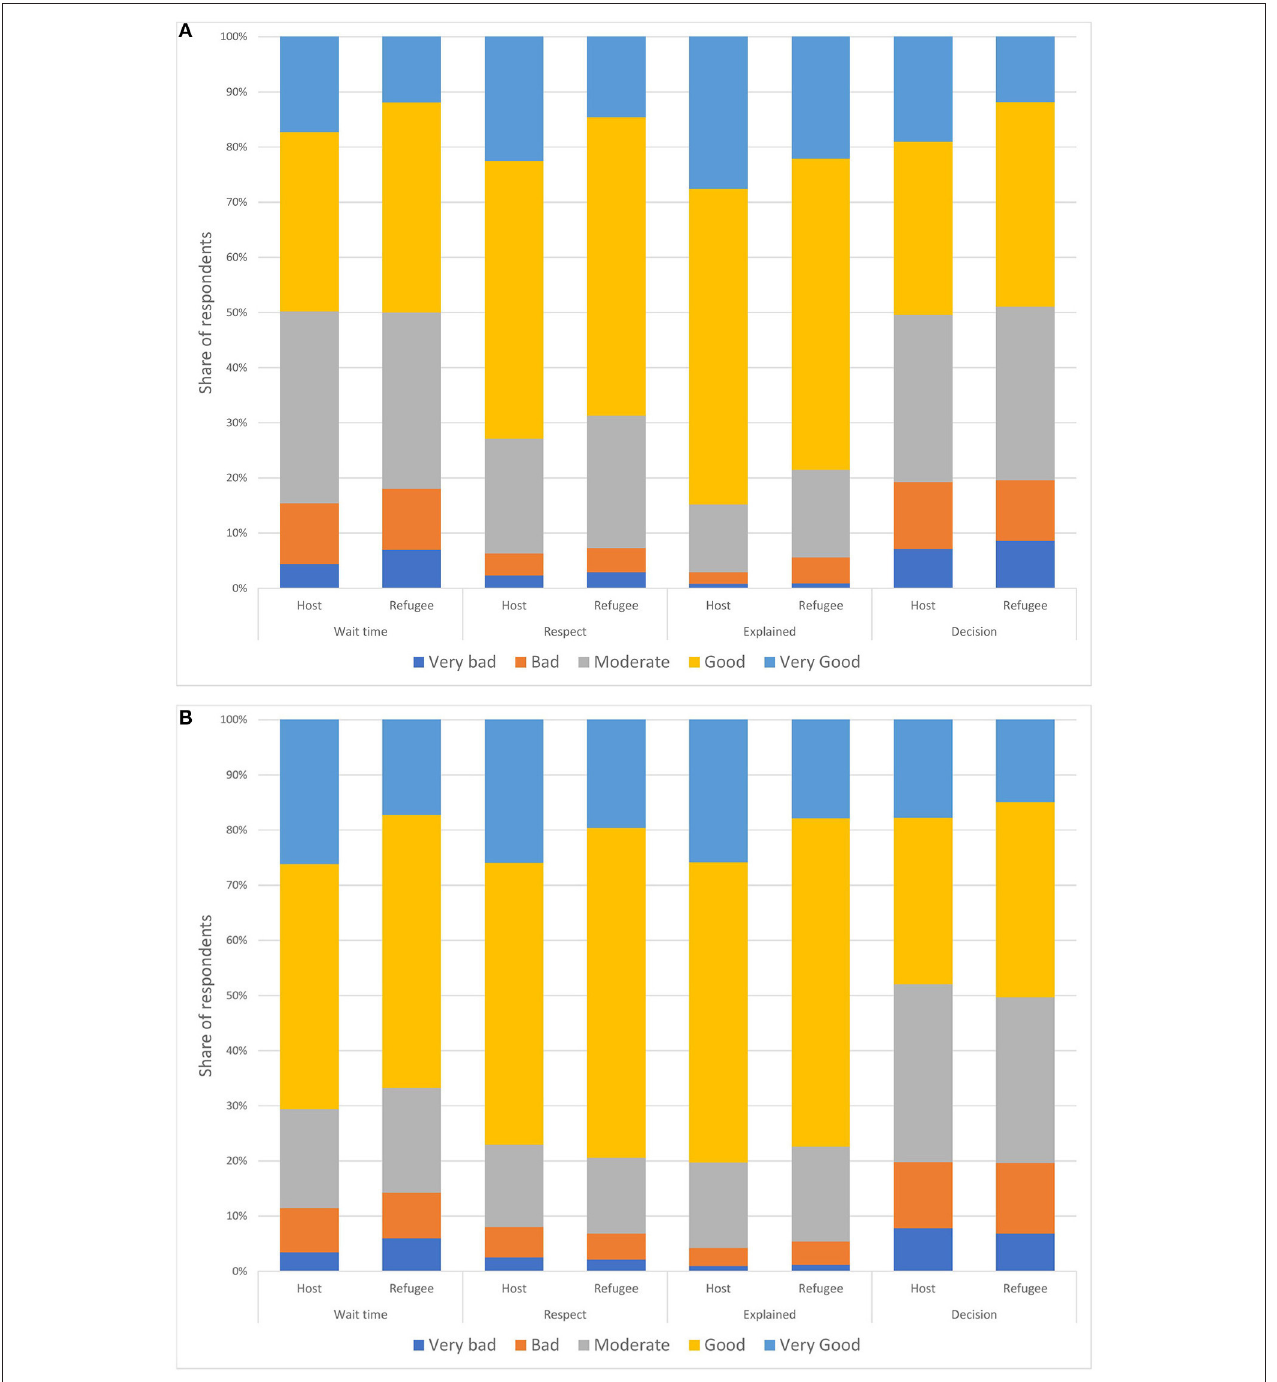
FIGURE 3 | Perceived quality of treatment by refugee status. Antenatal care in (A) and birth care in (B) .